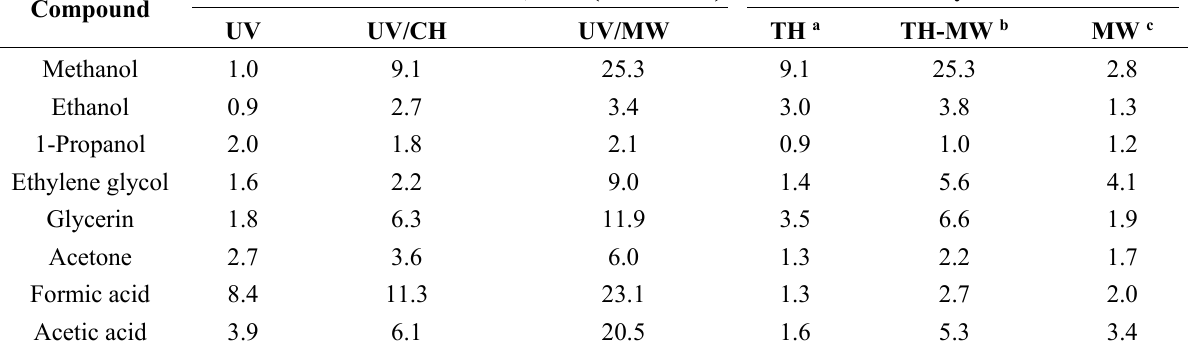
Table 1. Kinetics ( k ) in the loss of TOC for 0–120 min of irradiation by the UV, UV/CH and UV/MW methods, except for methanol, formic acid and acetic acid that were irradiated only for 0–90 min. TH factor: increased rate by UV/CH method relative to UV; TH-MW factor: increased rate by UV/MW method relative to UV; and MW factor: increase in rate by the UV/MW method with respect to UV/CH. Reproduced from ref. [36]. Copyright 2007 by Elsevier